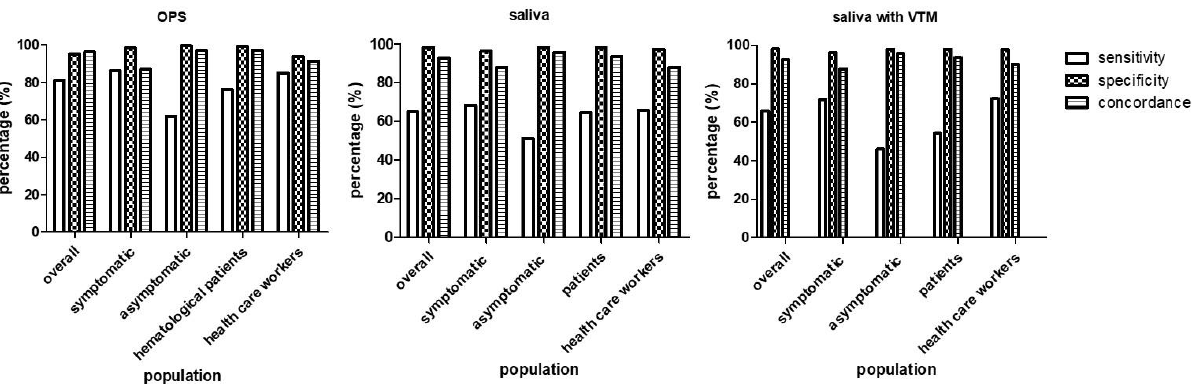
Figure 3. Accuracy of OPS and saliva tests according to the studied population, compared with NPS (the gold standard method). OPS: oropharyngeal swab, saliva-VTM: saliva with viral transport medium.